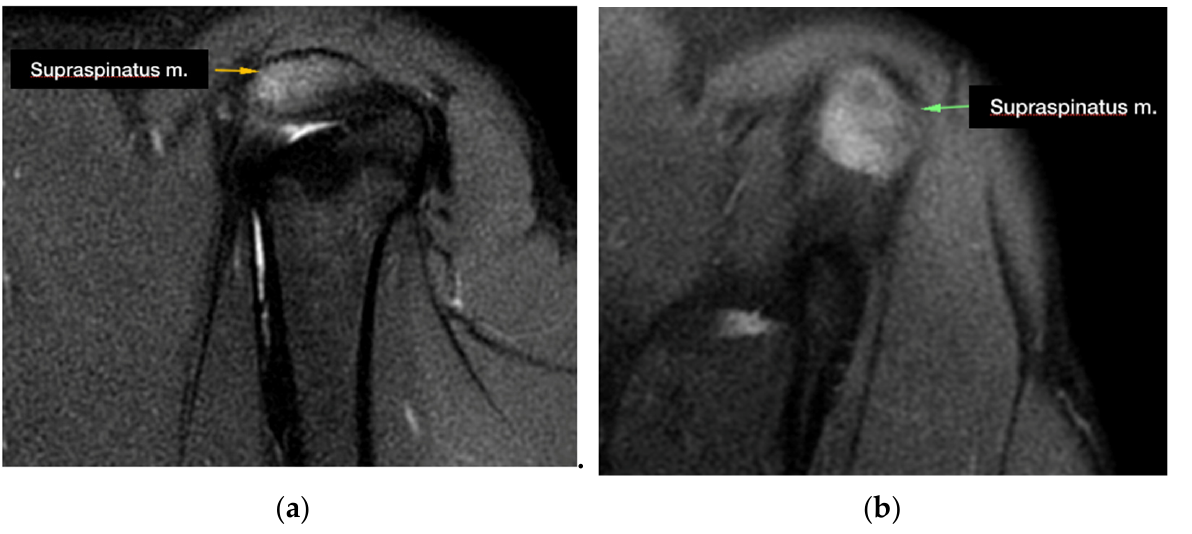
Figure 1. Supraspinatus tendon appearance during MRI imaging acquisition: ( a ) hyperintense signal at the level of the insertion of the supraspinatus tendon in the STIR images (sagittal plane); ( b ) hyperintense signal at the level of the insertion of the supraspinatus tendon in the STIR images (transverse plane). MRI abnormalities of the tendon of the subscapularis muscle were detected in one dog.